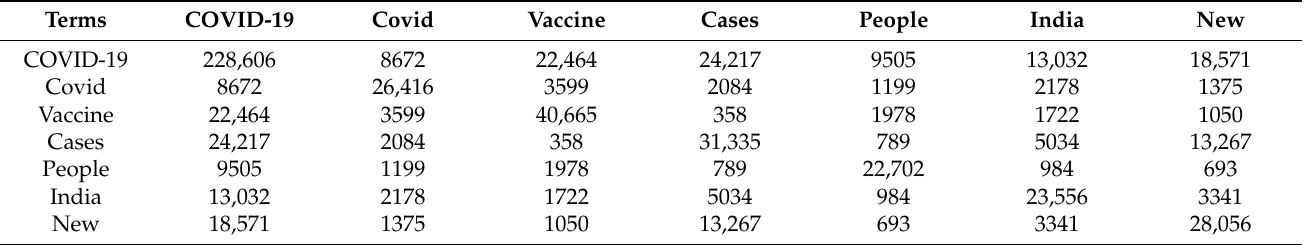
Table 2. The adjacency matrix of frequent